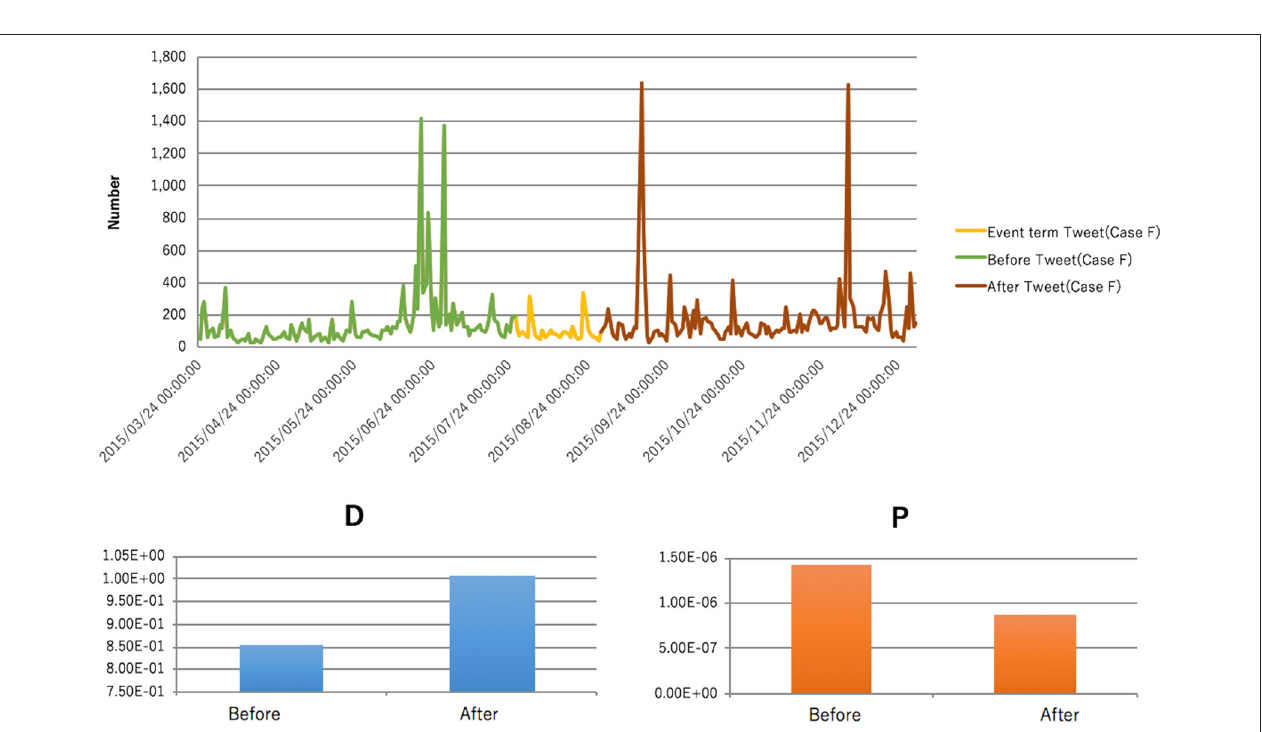
increase in direct communication, after the event at “Case F,” indicates an increase in the number of enthusiastic interested people. However, the fact that there is no increase in direct communication in the “Case E” indicates that “Case E” is only a topicality and there is no increase in “Case E” ’s core interested